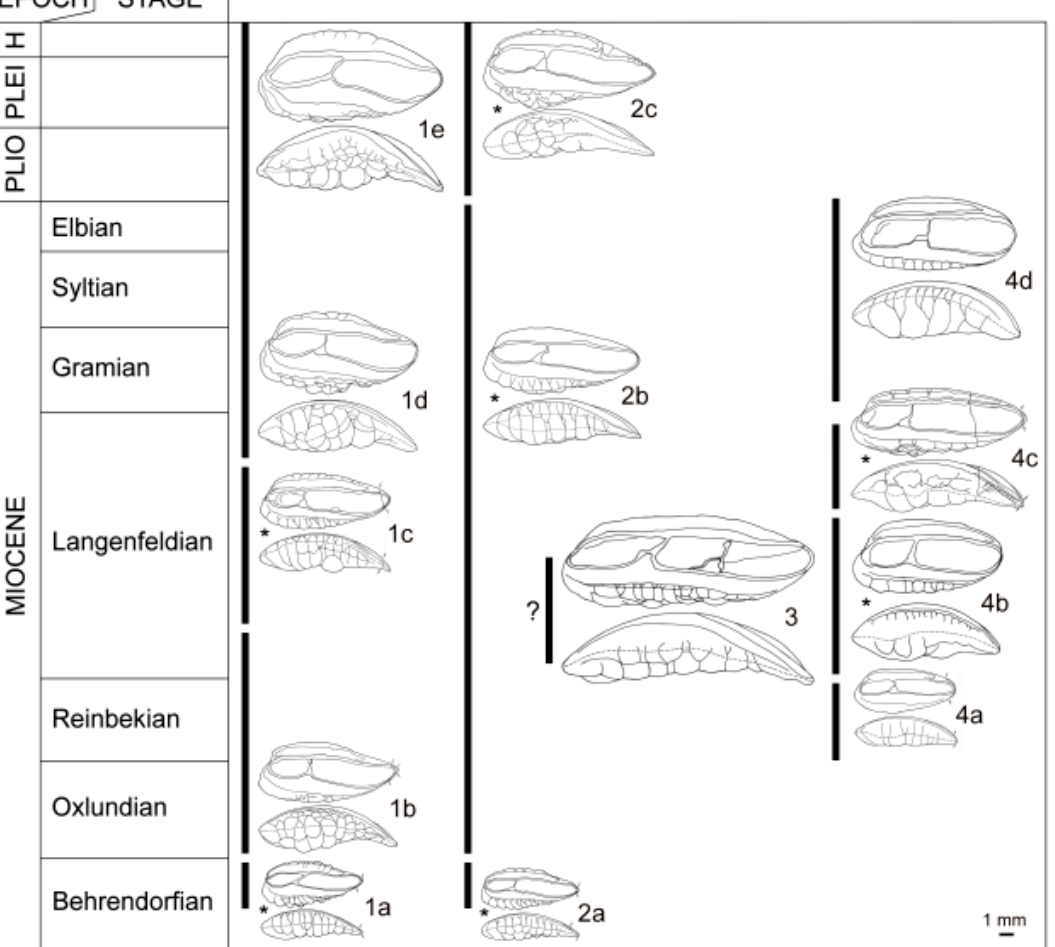
Figure 16. Evolutionary lineages of Trisopterus . Otoliths indicated with an asterisk are mirror images. ( 1a ) T. luscus n. ssp. 1, Behrendorfian, Edegem Sands, bed 6, Slijkhoek, Antwerp, Belgium; ( 1b ) T. luscus concavus (Gaemers, 1976), Oxlundian, Miste Bed, Miste, Winterswijk, The Netherlands. ( 1c ). T. luscus n. ssp. 2, Langenfeldian, borehole Straat, 518.7–520.7 m below surface, near Roermond, The Netherlands; ( 1d ) T. luscus luscus (Linnaeus, 1758), Gramian, borehole Straat, 494.7–495.7 m below surface, near Roermond, The Netherlands; ( 1e ) T. luscus luscus (Linnaeus, 1758), Recent, North Sea, TL 388; ( 2a ) T. capelanus n. ssp. 1, Early Miocene, Behrendorfian, Berchem Formation, Kiel Sands, borehole airfield Haamstede, The Netherlands, 132–133 m below surface; ( 2b ) T. capelanus n. ssp. 2, Gramian, Gram, Denmark; ( 2c ) T. capelanus capelanus (Lacepède, 1800), Recent, Aegean Sea, east of mainland of Greece, 50–100 m depth, female, TL 200; ( 3 ) † T. arcuatus (Radwanska, 1992), Badenian, Middle Miocene, Rybnica, Poland; ( 4a ) † T. spectabilis n. ssp. 1, Reinbekian, borehole Straat, 636.5–638.5 m below surface, near Roermond, The Netherlands; ( 4b ) † T. spectabilis spectabilis (Koken, 1891), Langenfeldian, Gross Pampau, Germany; ( 4c ) † T. spectabilis n. ssp. 2, Langenfeldian, borehole Straat, 524.7–526.7 m below surface, near Roermond, The Netherlands; ( 4d ) † T. spectabilis angustus (Gaemers and Schwarzhans, 1982), Syltian, Sylt, Germany.